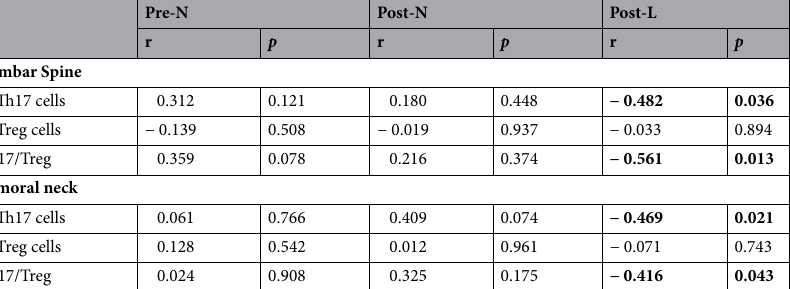
Table 3. Association of CD4 + T cell subsets with T score at lumbar spine and femoral neck in the study cohort. Data are represented as Spearman’s rank correlation and level of significance. p value < 0.05 is considered significant and marked in bold. Abbreviations: Pre-N premenopausal women with normal